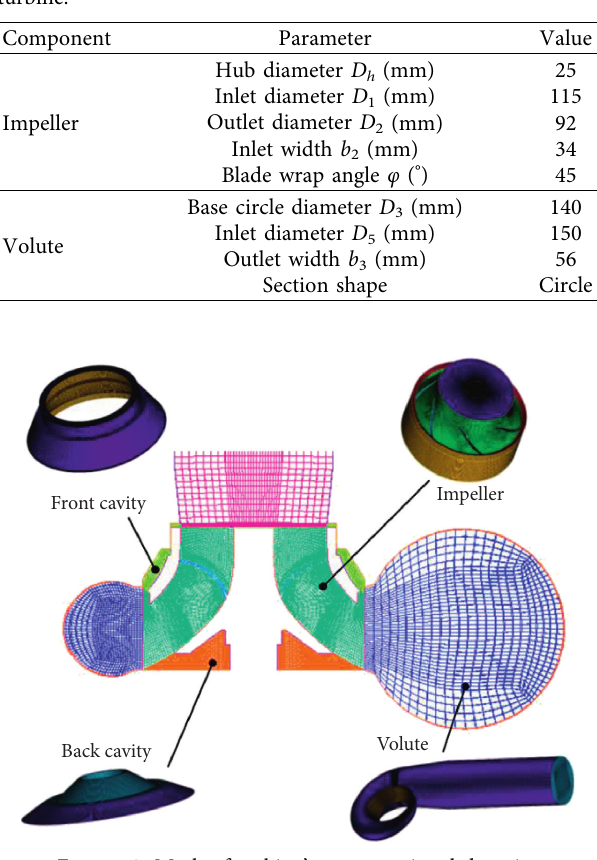
Figure 2: Mesh of turbine’s computational